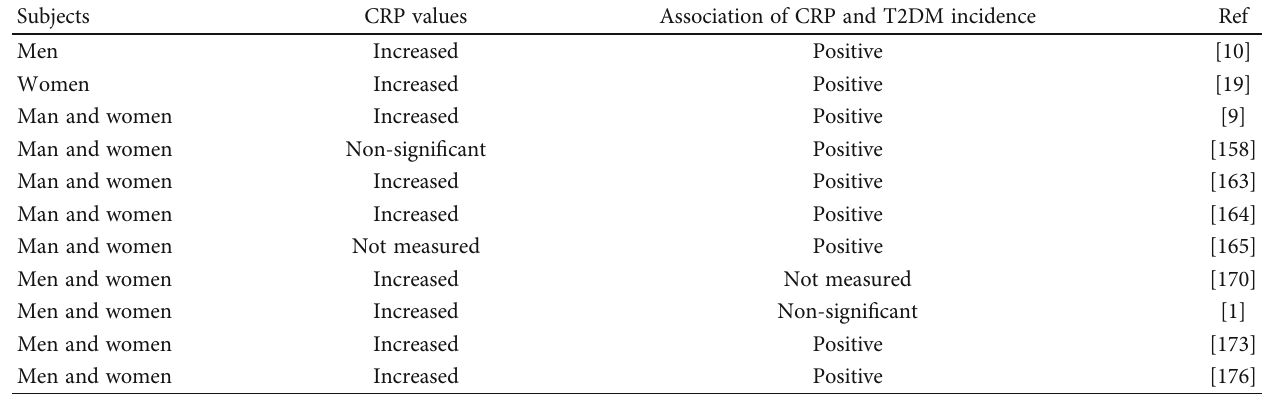
Table 2: CRP values in human